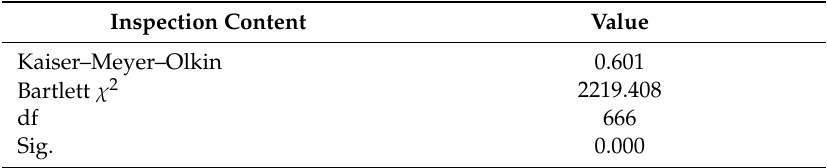
Table 1. Kaiser–Meyer–Olkin (KMO) and Bartlett sphericity